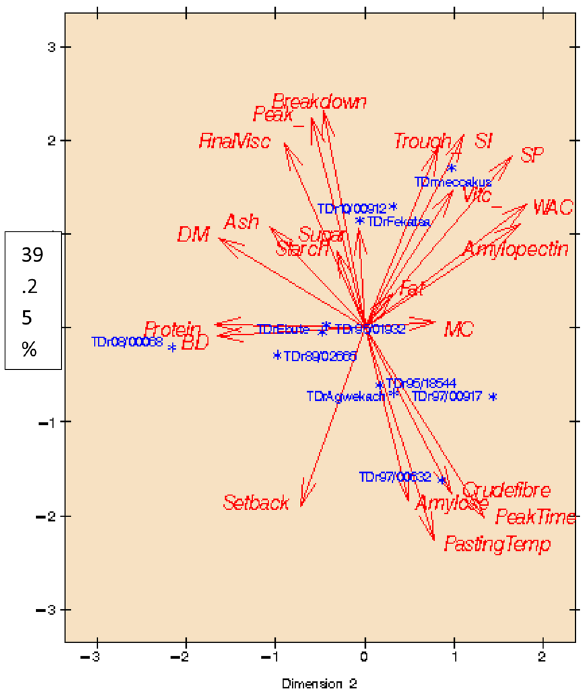
Figure 2. Principal Component Analysis of flour physicochemical and instant fufu product pasting attributes from D. rotundata control and improved